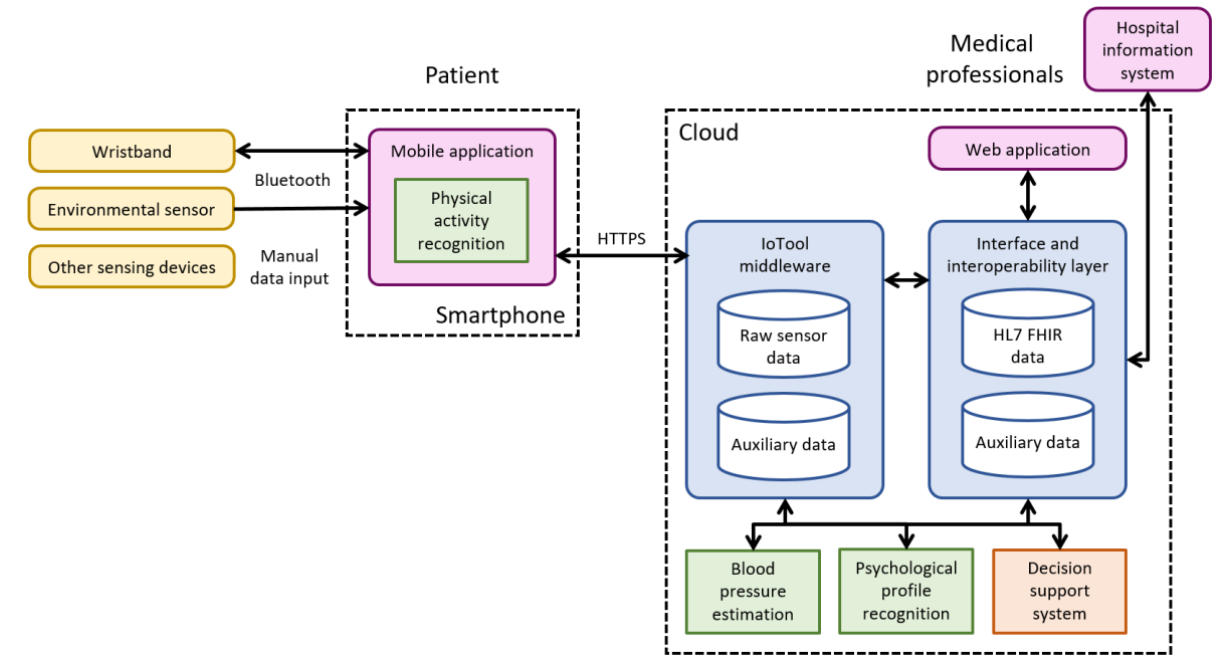
Figure 4. The physical architecture of the HeartMan